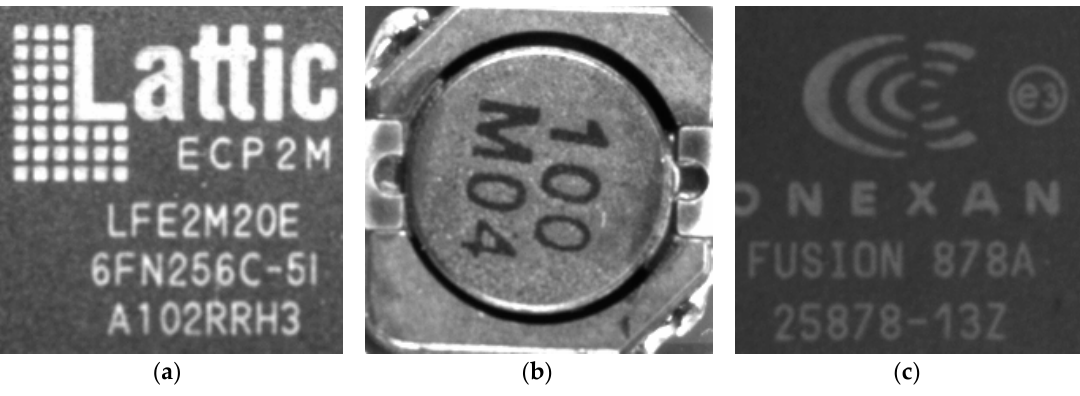
Figure 12. Images for the rotation test. ( a ) IC image 1; ( b ) Metal image; ( c ) IC image 2. Table 2. Errors for the rotation accuracy for both the proposed and compared methods.